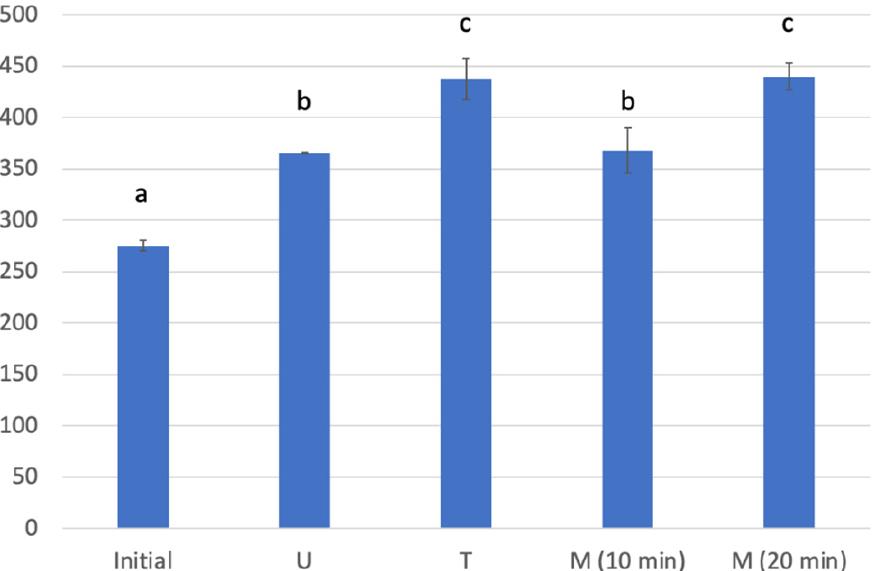
Figure 2. FCI (ppm gallic acid) obtained by the different extraction methods used. U: ultrasound; T: traditional; M: microwave 10–20 min extraction. Initial: Unmacerated vinegar sample. Different letters indicate significant differences according to Tukey’s test ( p < 0.05).